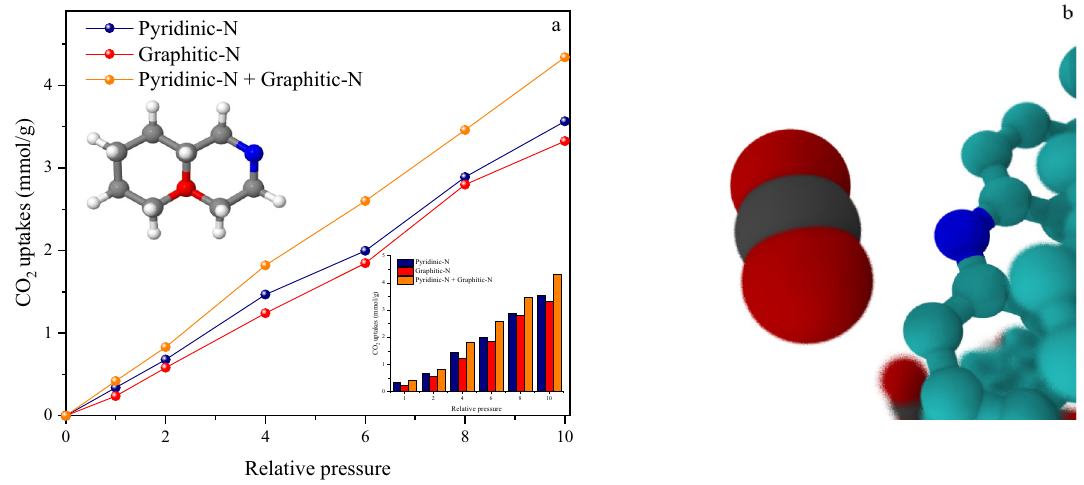
Figure 5. ( a ) CO 2 uptake isotherms simulation at 298 K under pressure range up to 10 bar on generated structure within the presence of Pyridinic-N (Blue), Graphitic-N (Red) and mixed of them (Orange); ( b ) Representative snapshot of CO 2 (Red–Black) nearby